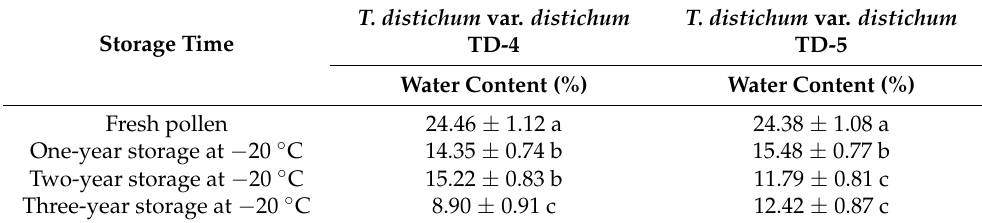
Table 3. The effect of different mass fraction of sucrose and boric acid on pollen germination of T. distichum var. distichum .